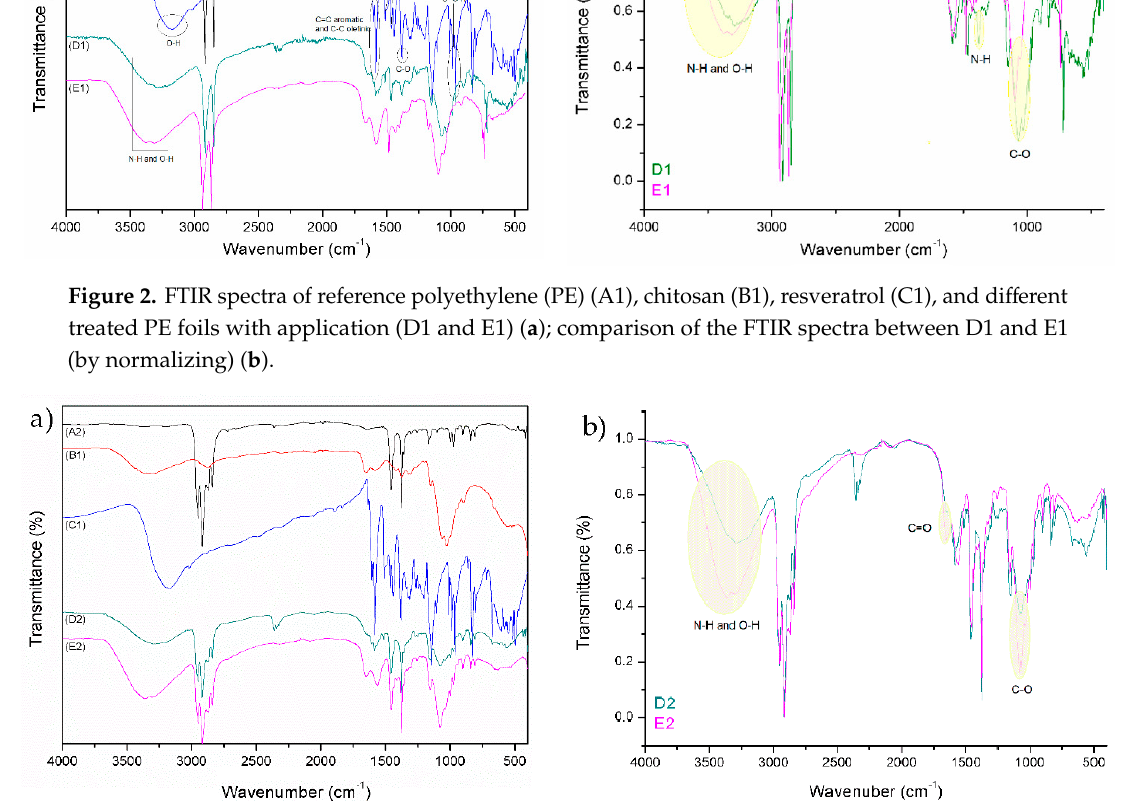
Figure 3. FTIR spectra of reference polypropylene (PP) (A2), chitosan (B1), resveratrol (C1), and di ff erent treated PP foils with application (D2 and E2) ( a ); comparison of the FTIR spectra between D2 and E2 (by normalizing) ( b